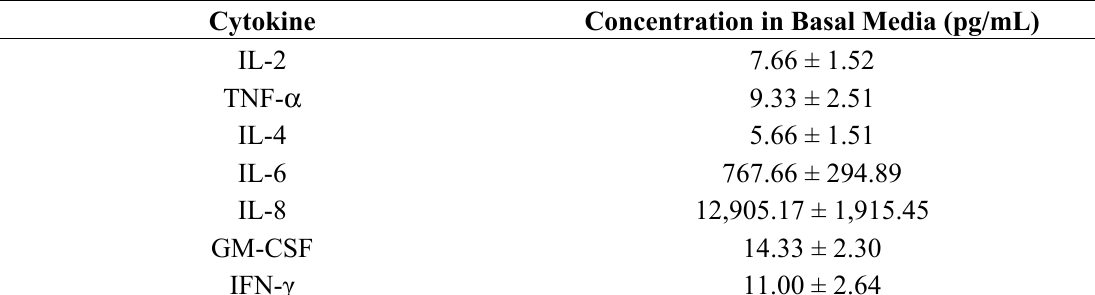
Table 1. Base-level secretion of eight cytokines by bio-plex cytokine assays